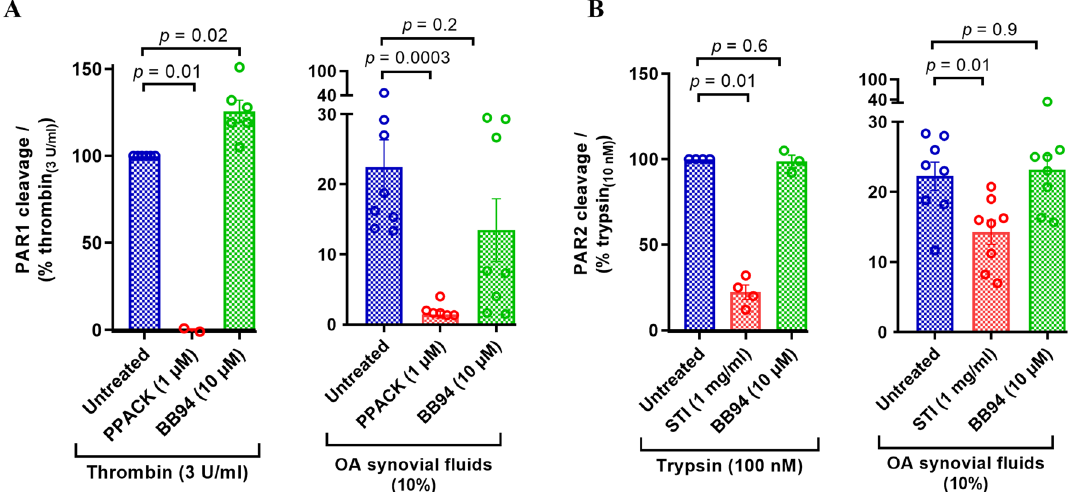
Figure 3. Effect of protease inhibitors on PAR cleavage by eight human OA knee joint synovial fluids. Standard PAR activating enzymes (thrombin for PAR1 and trypsin for PAR2) or synovial fluids (10%) were pretreated with an enzyme-selective inhibitor, PPACK, STI or BB-94, before addition to nLuc-hPAR-eYFP-CHO cells. Release of the N-terminal nLuc tag into the culture supernatants was monitored as an index of receptor N-terminus cleavage. ( A ) PAR1 cleavage and ( B ) PAR2 cleavage. Each bar represents the mean ± SEM ( N = 3–6). One-Way ANOVA Kruskal–Wallis test was utilized to assess differences between groups. p < 0.05 was considered statistically